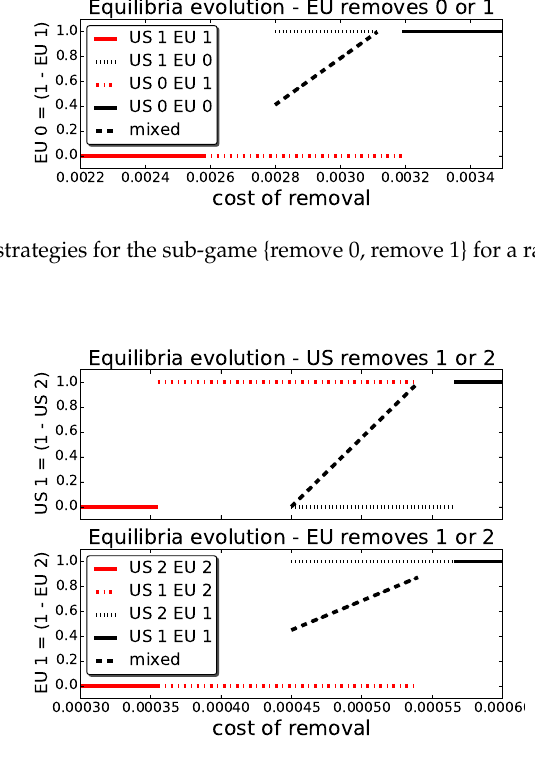
Figure 8. Equilibrium strategies for the sub-game {remove 1, remove 2} for a range of removal costs C r